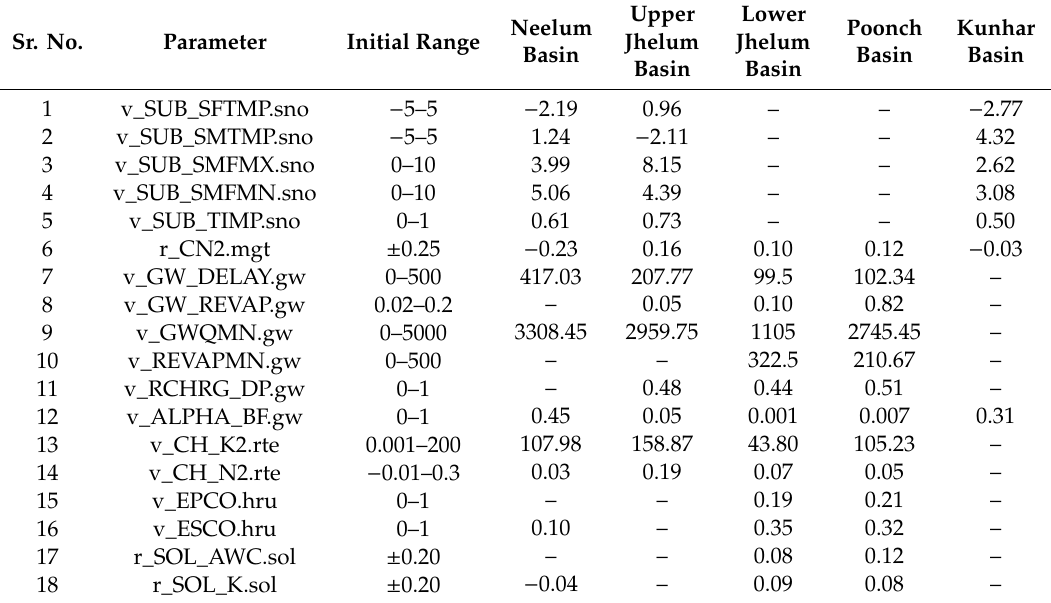
Table 4. Initial and calibrated parameters selected for the SWAT